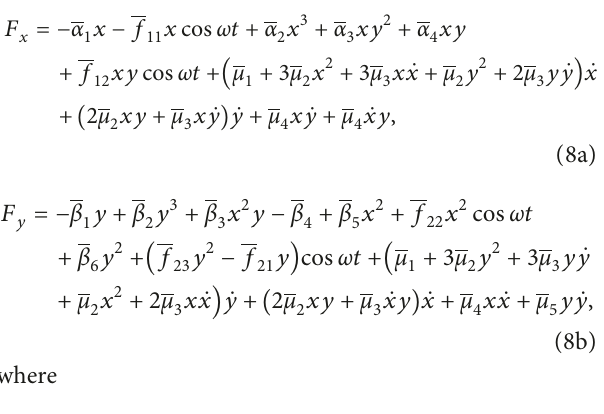
Figure 3: Electromagnetic force resultants of the rotor-AMB system with 16-pole legs obtained under different values of A electromagnetic force resultants F x in the x direction; (b) elec- tromagnetic force resultants F y in the y